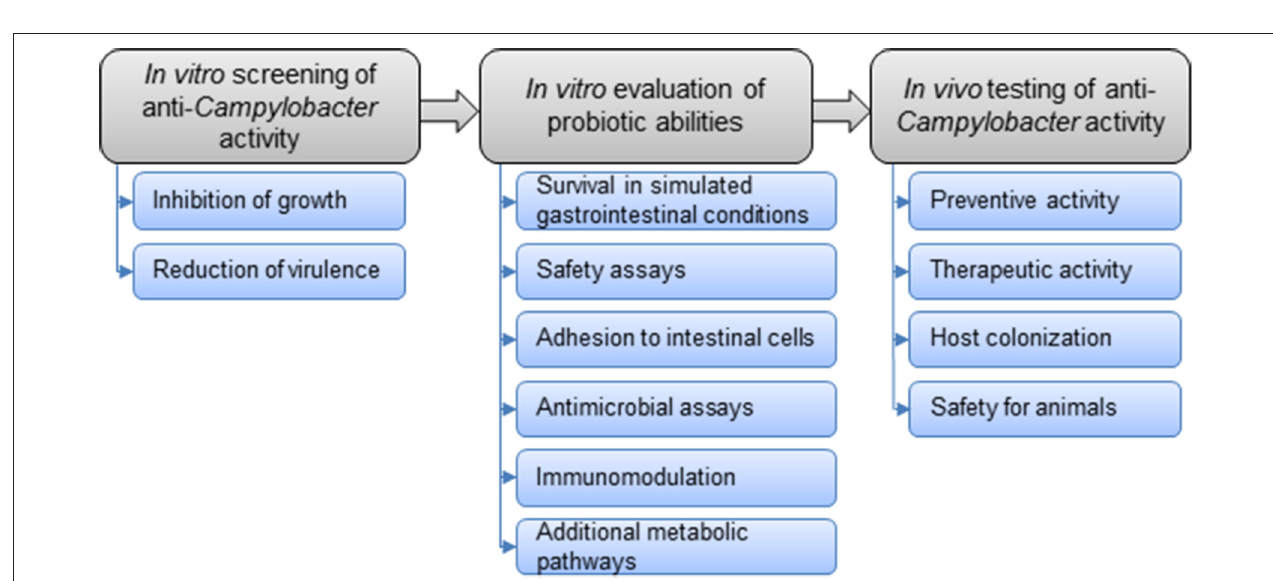
FIGURE 2 | Potential probiotic abilities to reduce Campylobacter in the avian gut. (1) Probiotics produce acidic compounds (lactic acid), which could inhibit Campylobacter and reduce the gut luminal pH that could affect Campylobacter (Neal-McKinney et al., 2012). (2) Probiotics compete for nutrients with Campylobacter ( Aho et al., 1992). (3) Probiotics produce bactericidal substances (bacteriocins, H 2 O 2 ) that could kill Campylobacter (Messaoudi et al., 2012a). (4) Probiotics strengthen tight junctions of intestinal epithelium and prevent Campylobacter translocation ( Messaoudi et al., 2012b). (5) Probiotics colonize intestinal epithelium and prevent adhesion and invasion of Campylobacter (Wine et al., 2009). (6) Probiotics bind Campylobacter (Nishiyama et al., 2014). (7) Probiotics alter the avian gut microbiota, which could affect Campylobacter colonization ( Sanders, 2011). (8) Probiotics modulate the immune system, which acts against Campylobacter (Brisbin et al., 2011).